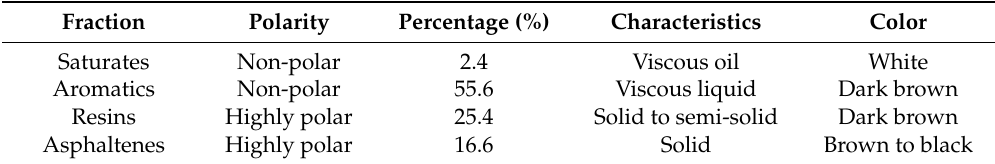
Table 2. SARA fraction characteristics of the neat bitumen.